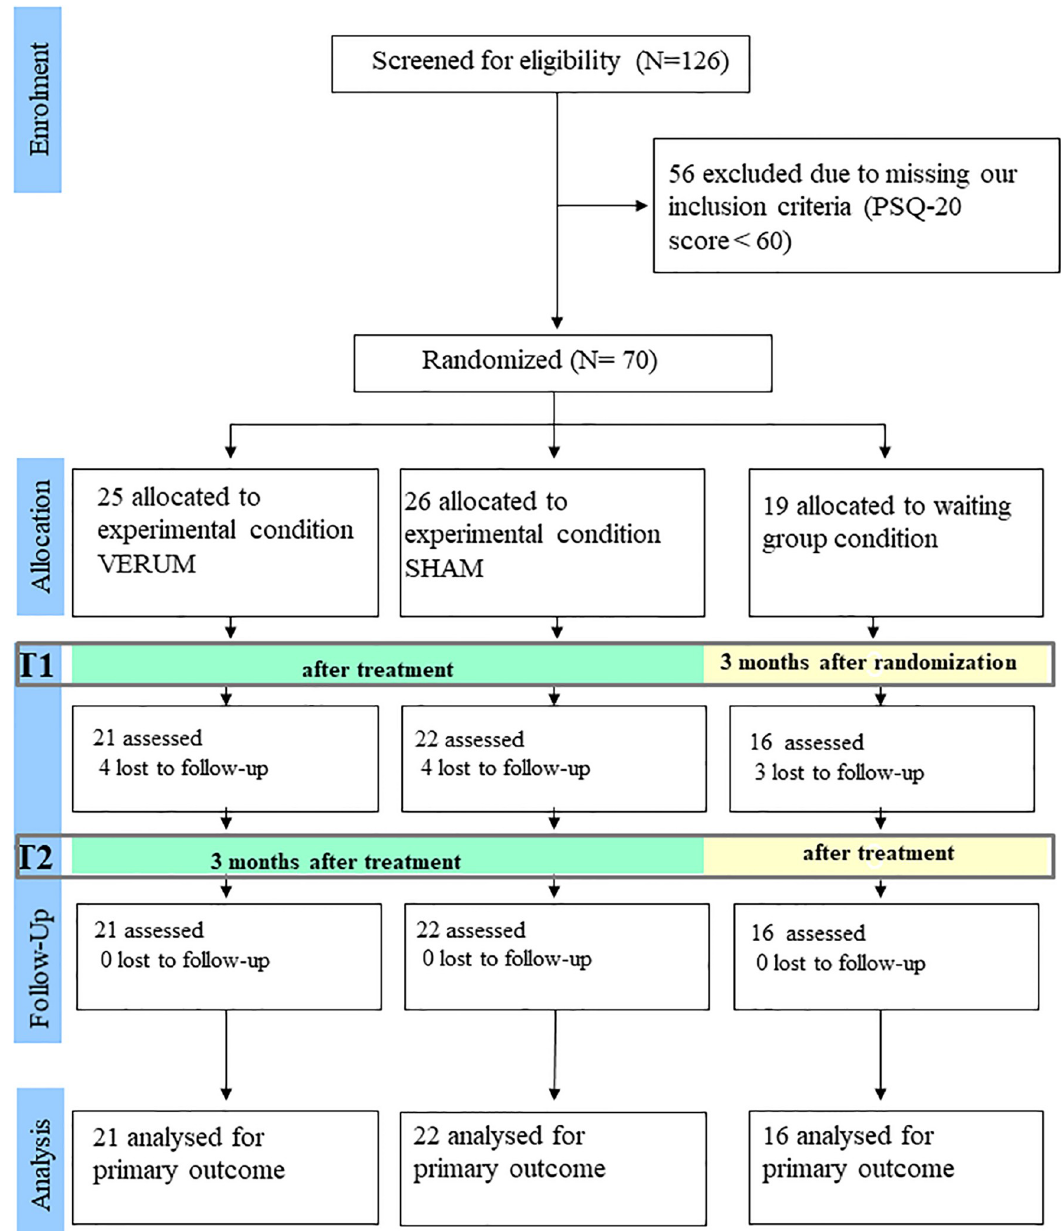
Fig 1. Trial flow of the